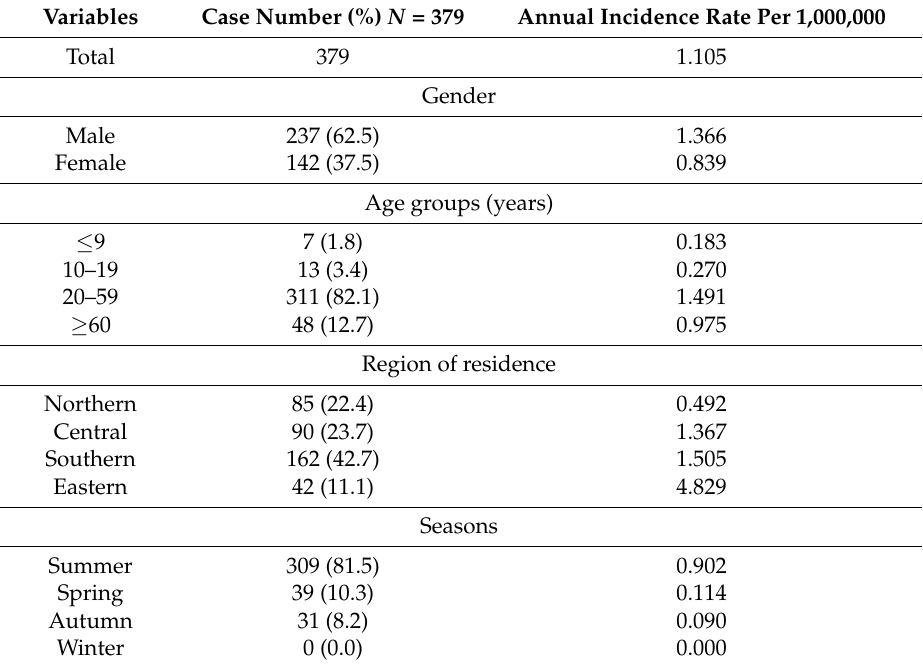
Table 1. Demographic characteristics of patients with Japanese encephalitis in Taiwan,